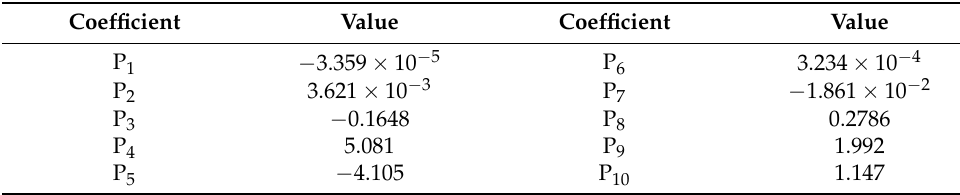
Table 4. Coefficients for polynomial fitted curves.